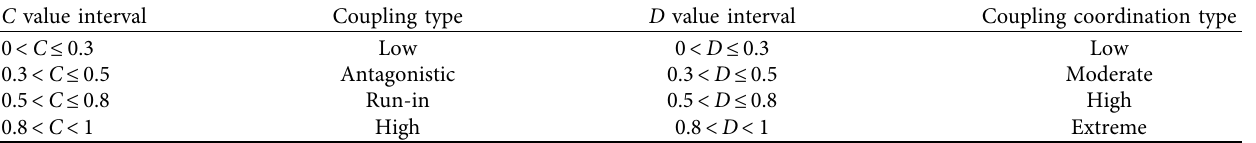
Table 1: Classification of coupling degree and coupling coordination degree.